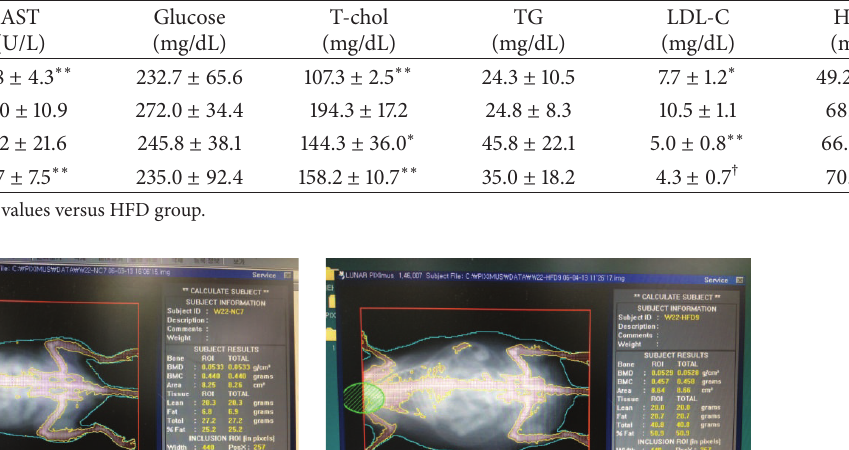
Table 1: Liver function and lipid profiling.